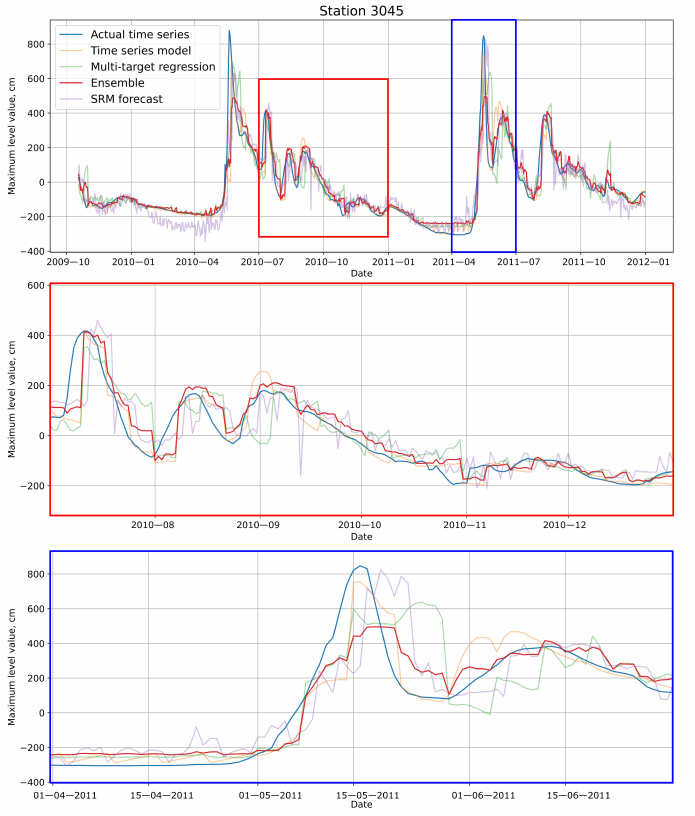
Figure 15. Forecasts of individual blocks and ensemble on the validation part. The most relevant parts of time series are shown in the sub-figures. Forecast horizon is seven